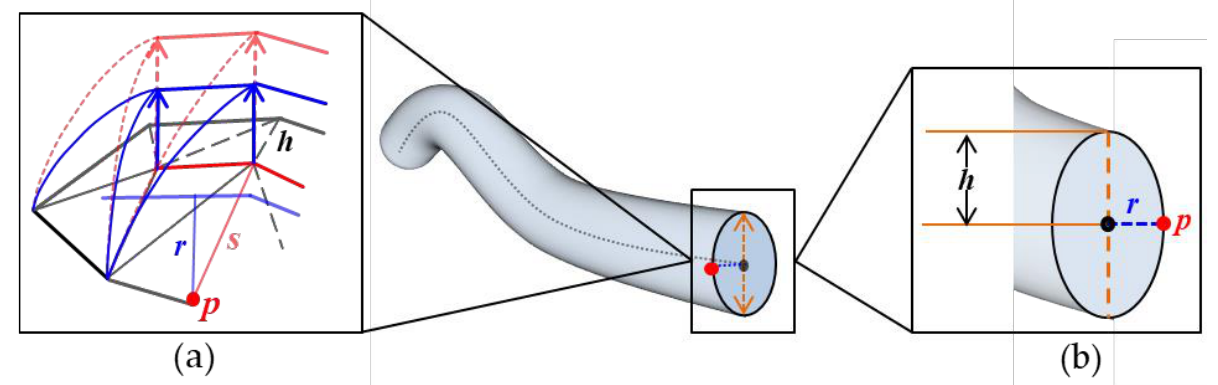
Figure 4. Schematic diagram of ridge elevation. ( a ) shows that the expansion height defined in this paper is different from that in the literature [63]. The distance from a point p of the profile to the ridgeline is s (red), the distance to the midline of the profile is r (blue), and the height of the ridge elevation is h . ( b ) Schematic diagram of the transverse interface where the profile point p is located.